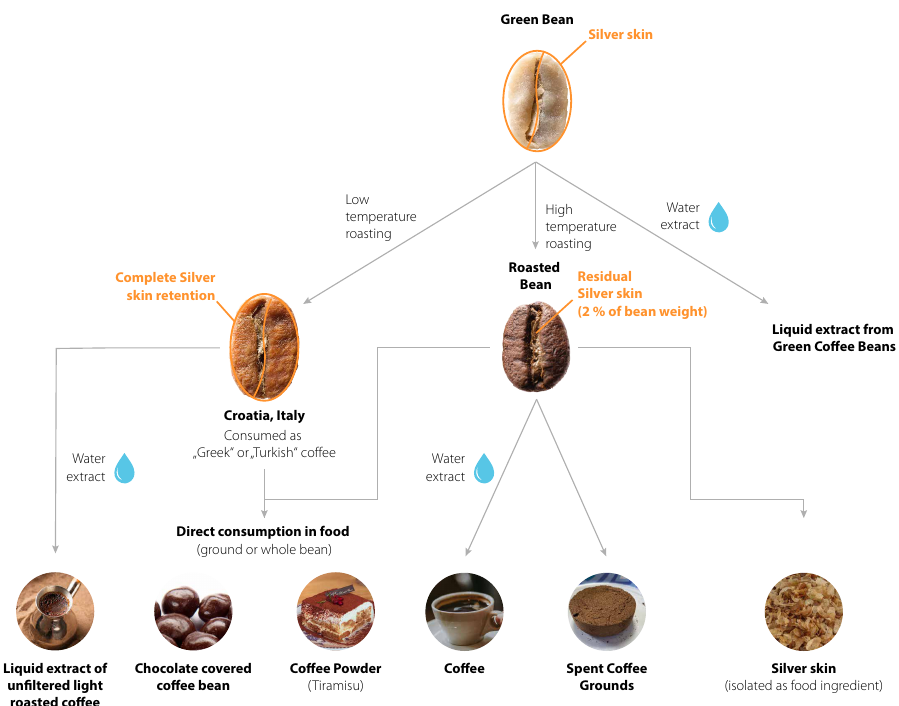
Figure 3. Various direct and indirect forms of human consumption of silver skin from coffee (the content of silver skin shown in yellow). Starting from the unroasted green coffee bean, roasting and brewing lead to the various coffee products. While all other shown products containing silver skin are not novel, isolated silver skin was considered as a novel